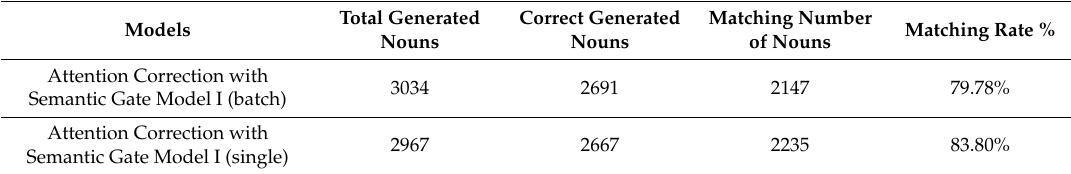
Table 5. Results of the 2 training modes of the semantic gate and attention model.